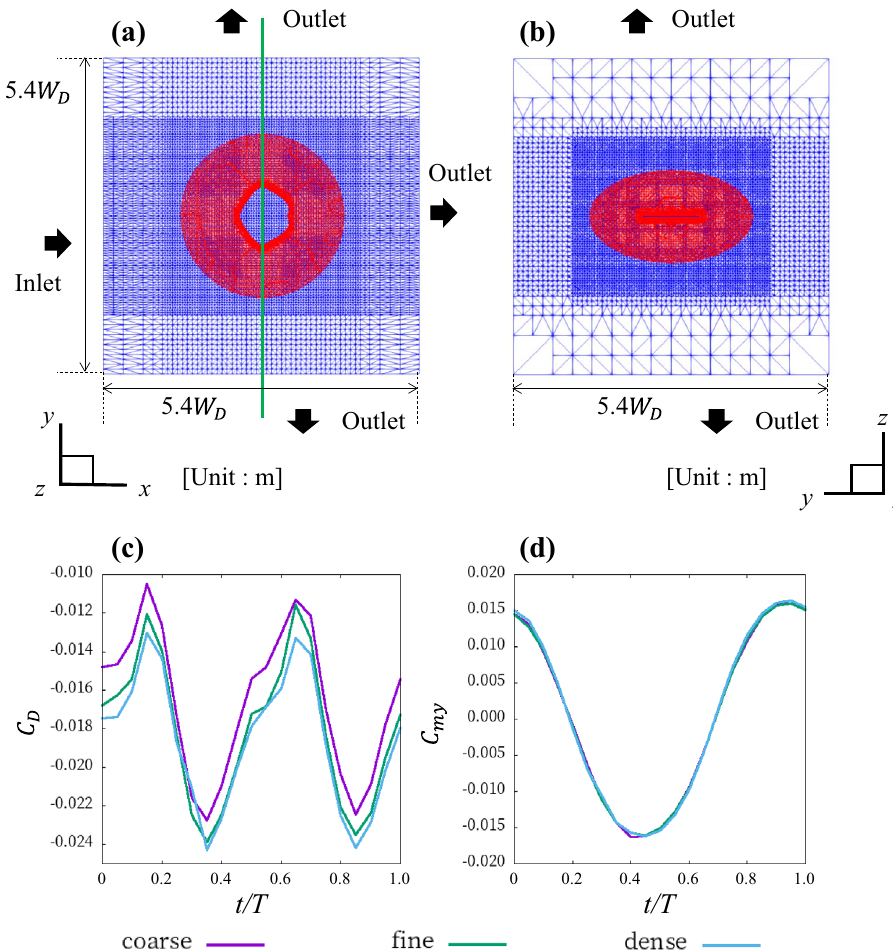
Figure 2. Meshes for CFD simulation and differences in force between different meshes. ( a ) Meshes at the coronal plane of the whole fluid region. ( b ) Frontal cross-section of the fluid region at the green line in ( a ). The red region is the overset region. ( c , d ) Comparison of the instantaneous drag coefficient and the moment coefficient around the y -axis of D. matsubarai between the coarse, fine, and dense